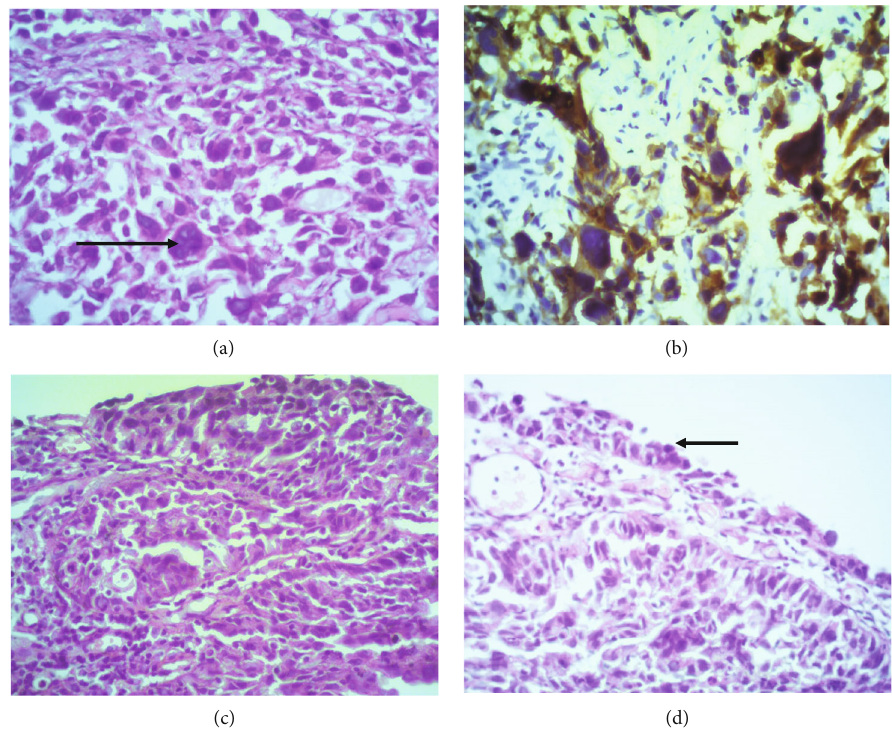
Figure 1: Histological appearance of the tumour. Giant cell urothelial carcinoma comprising sheets of pleomorphic cells with admixed bizarre mononuclear and multinuclear giant cells ((a), haematoxylin and eosin × 400) which were positive for pancytokeratin ((b), AE1/AE3 × 400) admixed with areas of conventional urothelial carcinoma (c) and carcinoma in situ